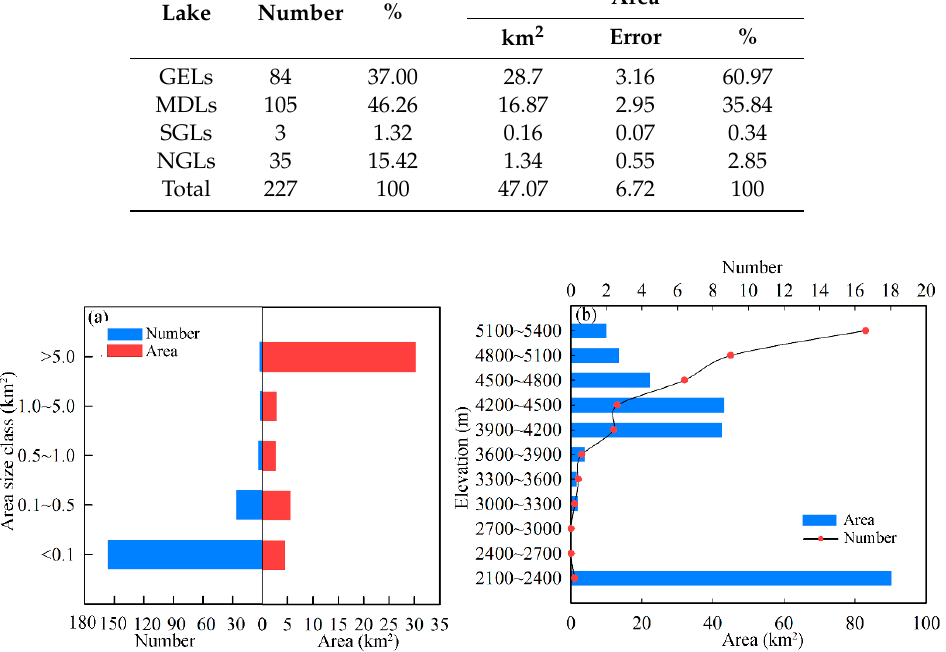
Figure 2. Distribution of glacial lakes in di ff erent area size classes and elevation intervals of the Yi’ong Zangbo River Basin in 2016 (( a ) numbers and areas of glacial lakes with di ff erent size classes and ( b ) with di ff erent elevation